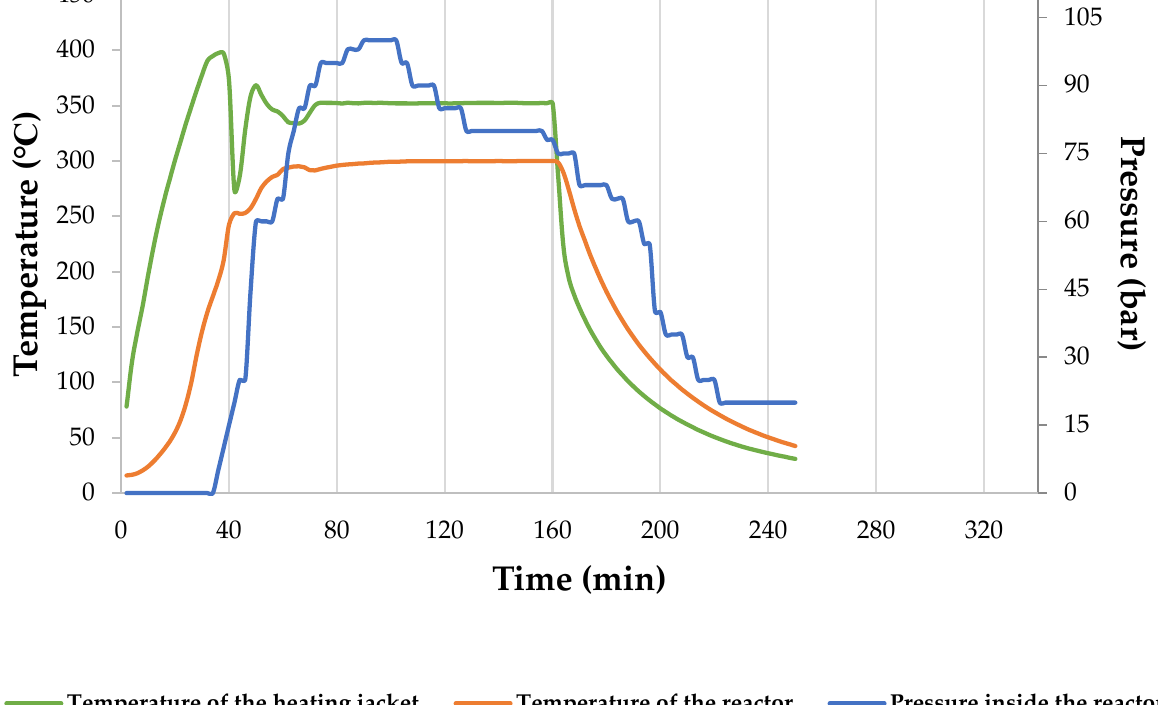
Figure A8. Temperature and pressure patterns during the process at 300 ◦ C in 90 min.